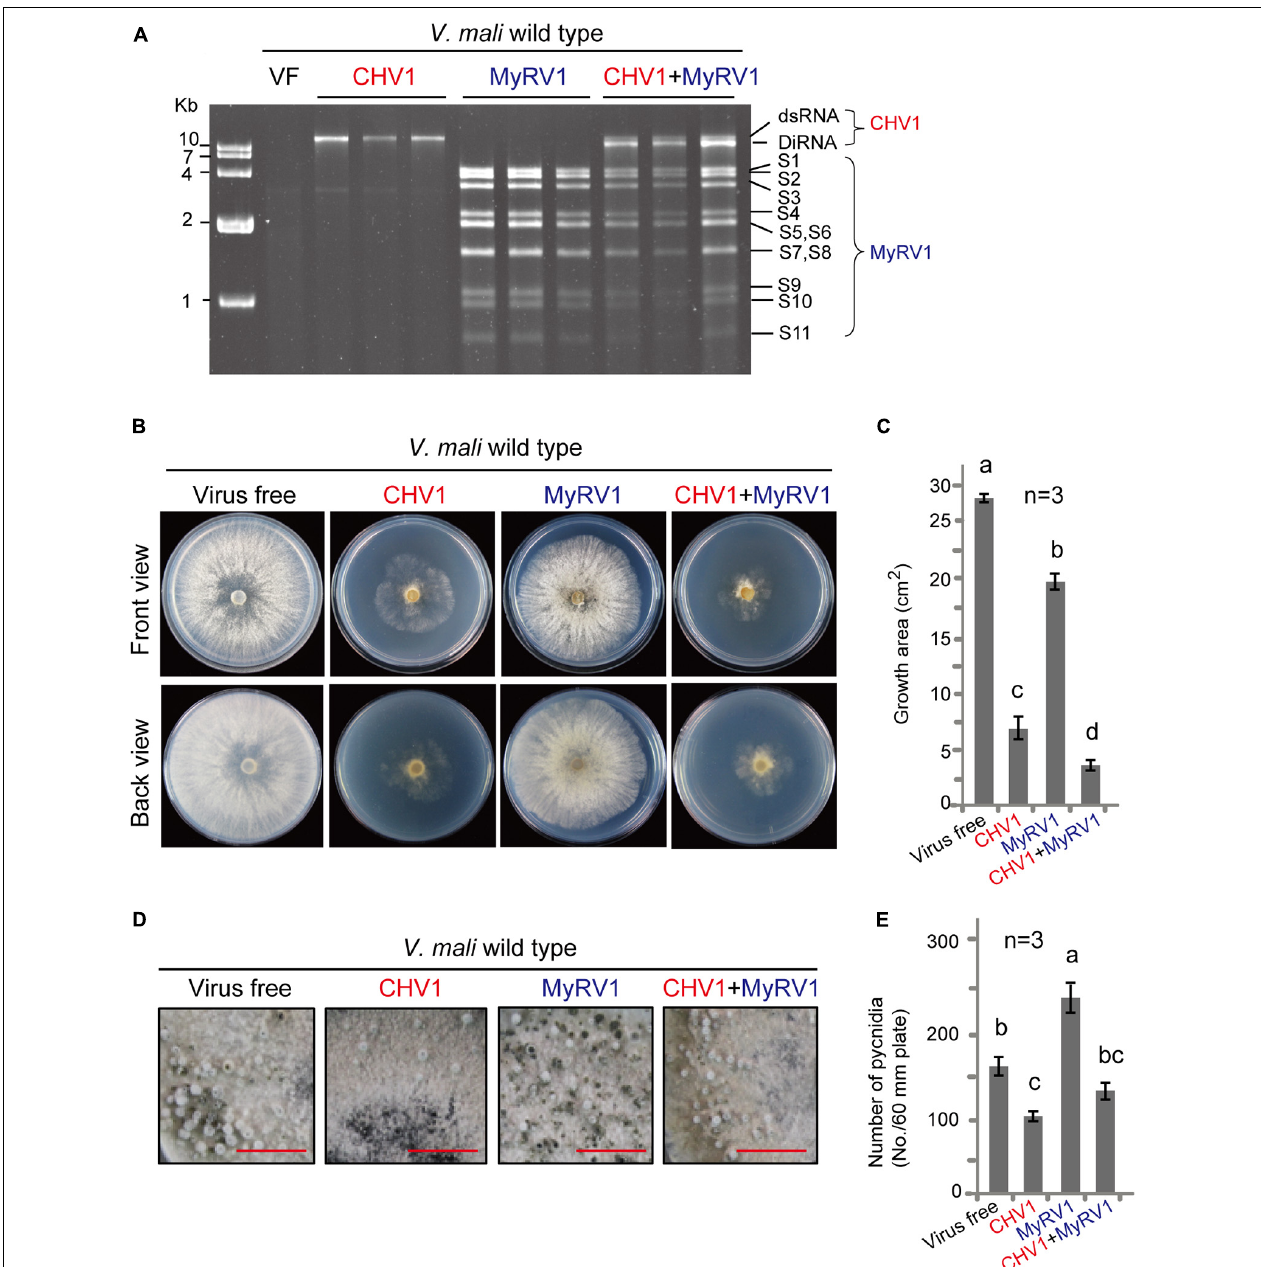
FIGURE 1 | Infection of CHV1 and MyRV1 in V. mali . (A) Agarose gel electrophoresis of dsRNAs extracted from V. mali strains singly or doubly infected with CHV1 and MyRV1. The dsRNA samples were analyzed via electrophoresis in an agarose gel stained with ethidium bromide. The CHV1 dsRNA bands that migrated slightly faster than the wild-type CHV1 are defective interference RNA (DI-RNA). (B) Phenotypic growth on PDA medium of representative V. mali strains singly or doubly infected with CHV1 and MyRV1. The colonies were grown on PDA for 4 days and then photographed. (C) The growth areas of fungal strains described in (B) . The data are the means ± SD ( n = 3). The different letters indicate a significant difference at p < 0.01 (one-way ANOVA). (D) Representative images showing the formation of asexual fruiting bodies (pycnidia) of the fungal strains described in (B) . The fungi were cultured on PDA medium for 4–5 weeks until the pycnidia were produced. Bars equal 1 cm. (E) The number of pycnidia counted from the fungal strains described in (D) . The data are the means ± SD ( n = 3). The different letters indicate a significant difference at p < 0.01 (one-way